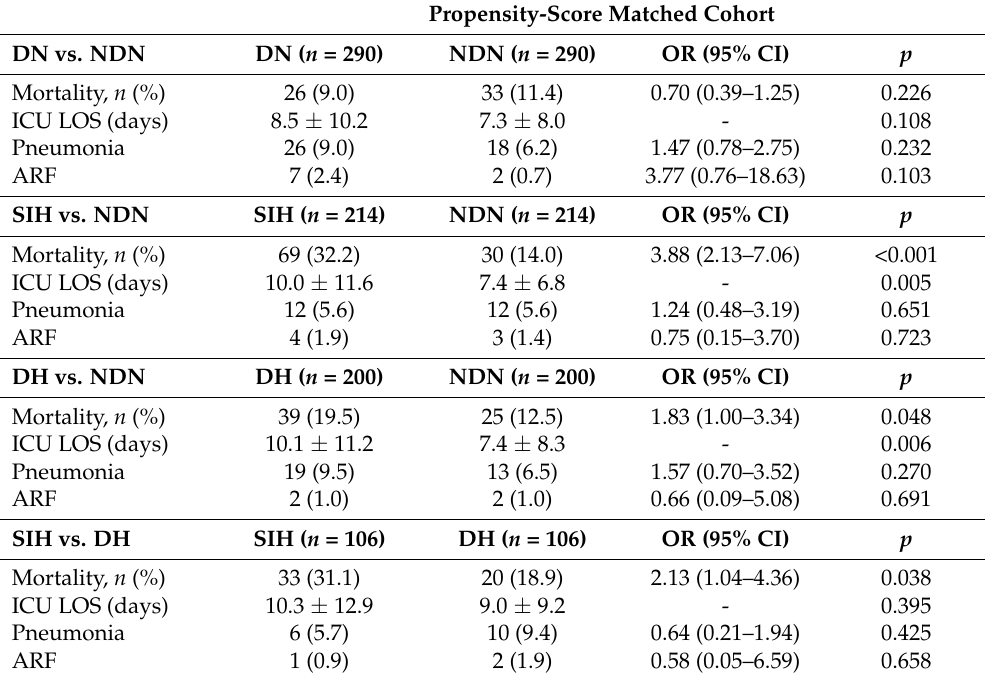
Table 4. Outcomes comparison among the selected propensity score-matched